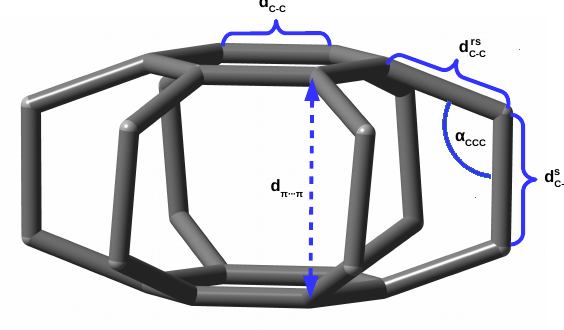
Figure 1. Structure of the superphane (i.e., [2.2.2.2.2.2](1,2,3,4,5,6)cyclophane) molecule (hydrogen atoms are removed for clarity) and labels of the most important geometric